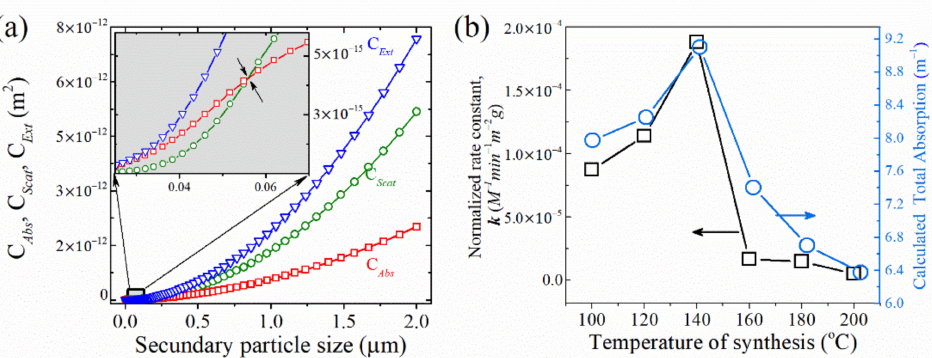
Figure 11. ( a ) Scattering, absorption, and extinction cross sections as a function of the particle size, calculated according to the Mie’s theory. The inset corresponds to a zoom at smaller particle sizes to show the crossover of the absorption and scattering coefficients. ( b ) Normalized rate constants (TORs) of photocatalysis and calculated total absorption coefficient for the TiO 2 NPs synthesized at different temperatures (100–200 ◦